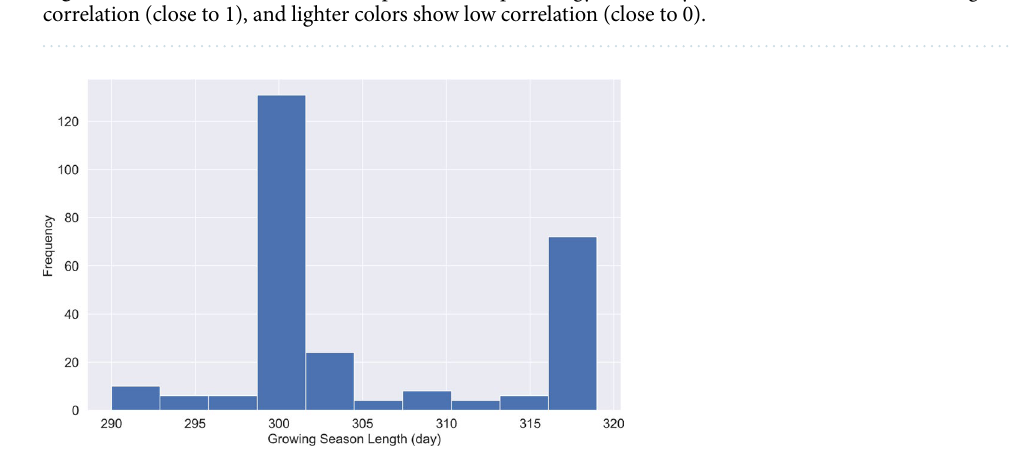
Figure 2. Frequency distribution of growing season length (from sowing to harvest) across the 271 counties in